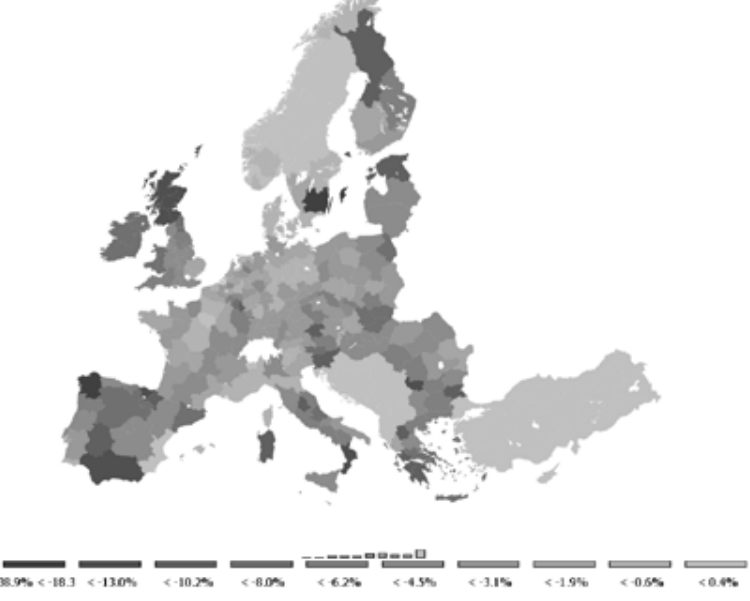
Source: Own map based on CAPRI-results.